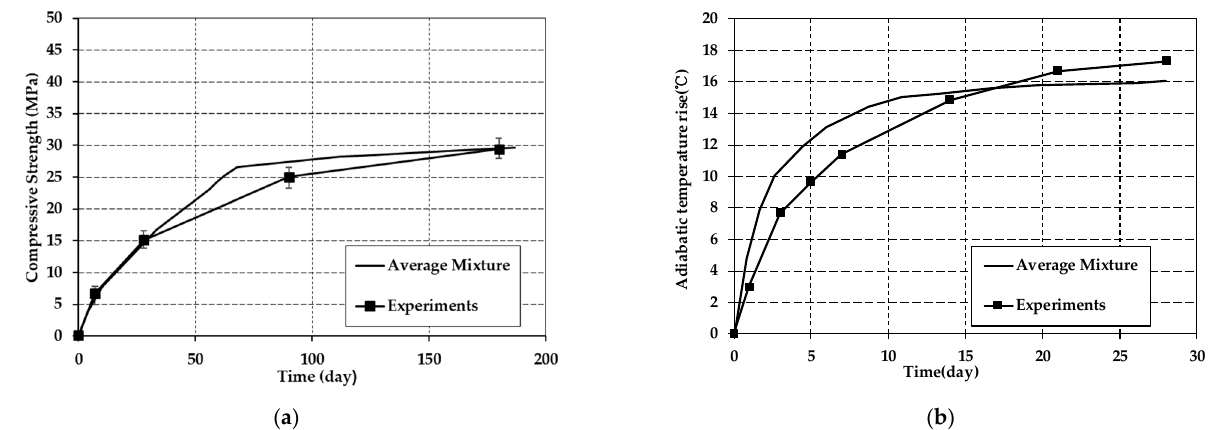
Figure 8. Comparison between experimental and simulated results: ( a ) Simulation results of compressive strength; ( b ) simulation results of adiabatic temperature rise.